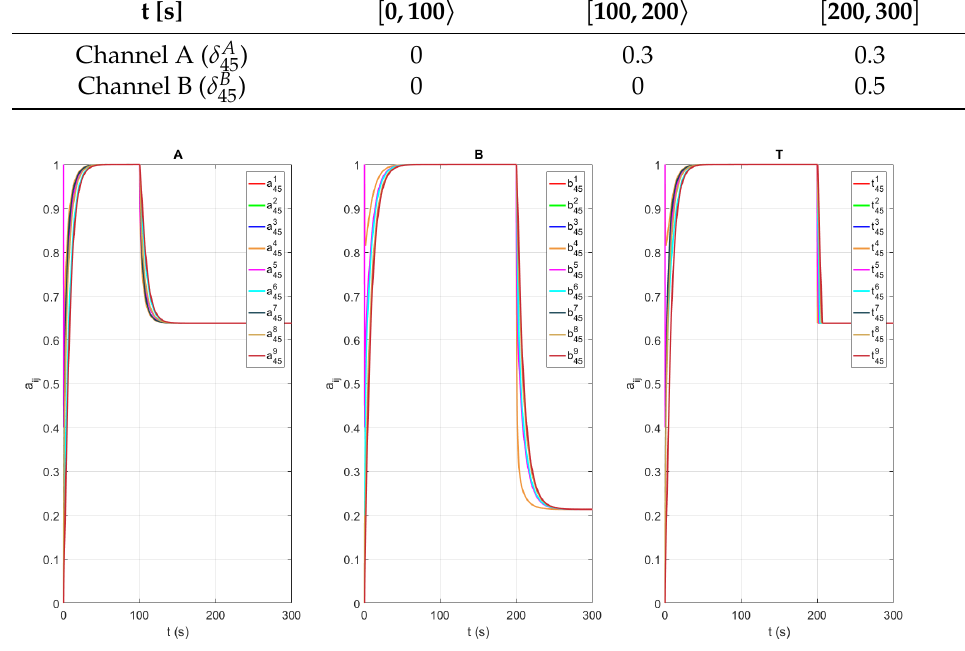
Figure 6. Adjacency matrix element (4,5) responses for channels A, B, and